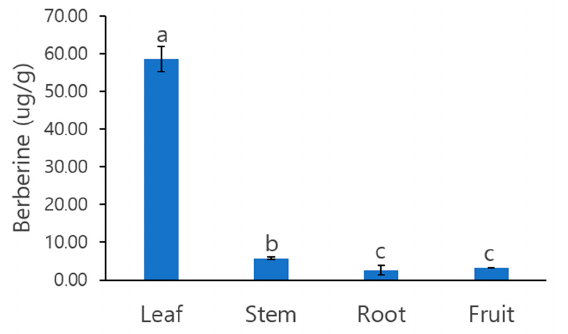
Figure 1. Berberine content in the four organs of C. robustum . Data followed by a different letter indicate significant differences between samples according to one-way ANOVA/Duncan test ( p <